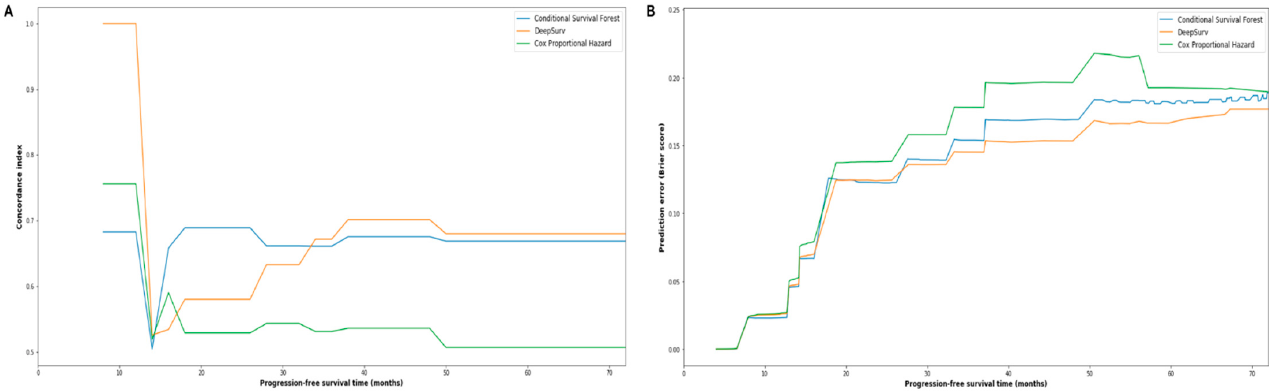
Figure 3. Plots of time-dependent concordance index (c-index) ( A ) and prediction error (Brier score) ( B ) comparing the three models.